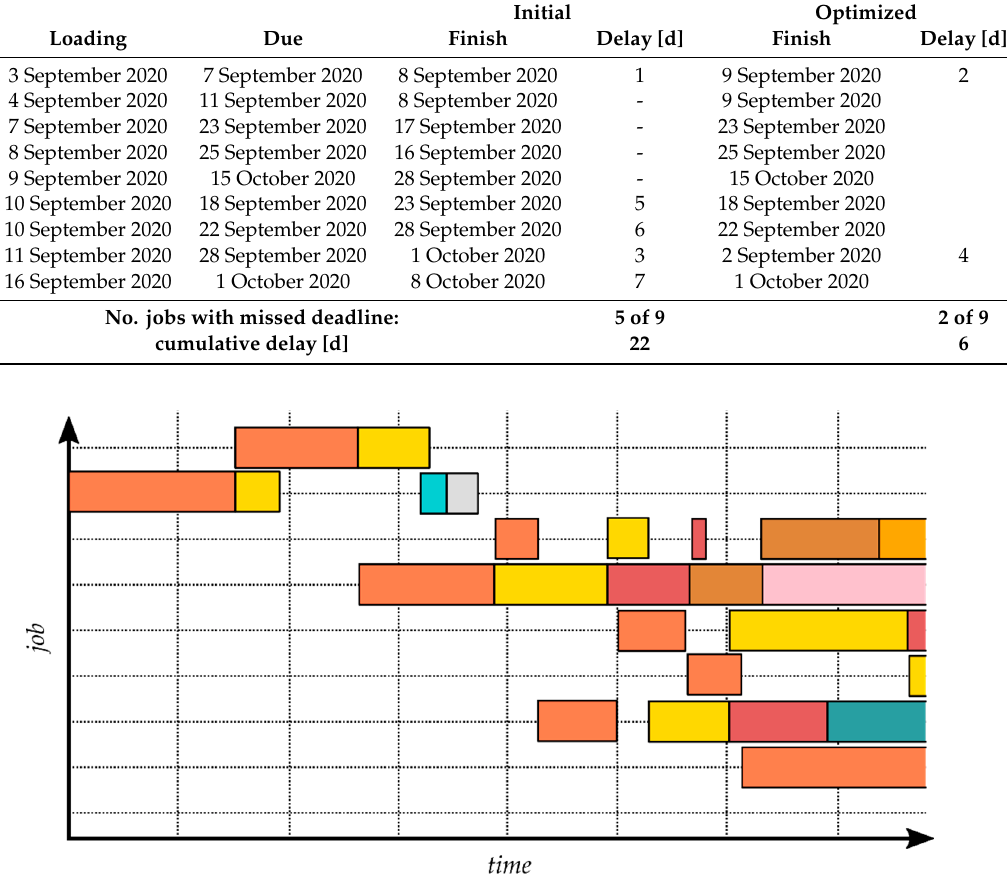
Figure 5. Production schedule prior to optimization for the use-case. J. Manuf. Mater. Process. 2020 , 4 , x FOR PEER REVIEW